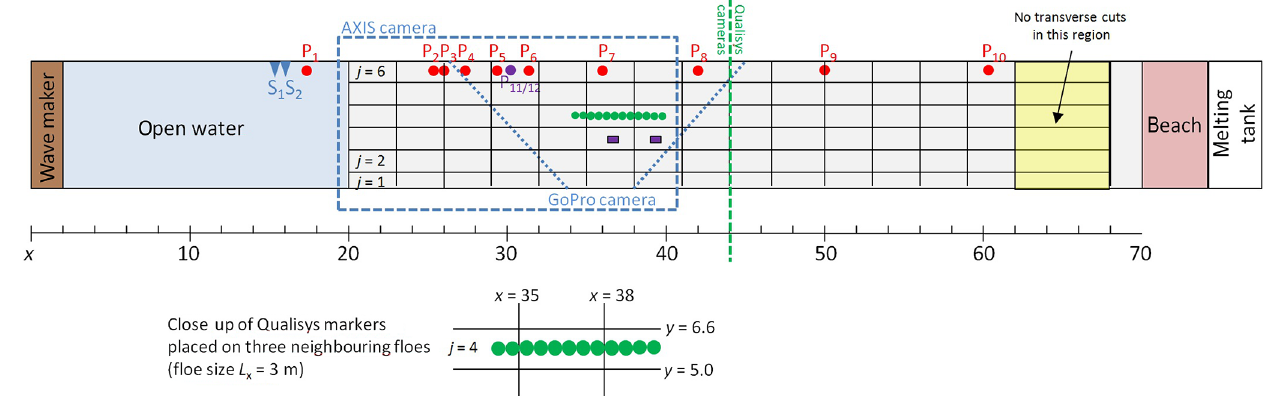
Figure 1. LS-WICE experiment set-up. The ice edge is located at x 0 = 20m, the grey area represents the ice sheet (at the stage when it was cut into floes with L x = 3m). Red dots numbered P 1 ,...,P 10 show positions of pressure sensors, point P 11 /P 12 shows position of a double pressure sensor (measuring at two different depths), and S 1 and S 2 show positions of ultrasound sensors. The dashed and dotted blue lines mark the fields of view of the AXIS camera mounted at the ceiling and the GoPro camera mounted at the side of the basin. Green dots mark the Qualisys markers placed on the fourth row of ice floes (shown in more detail in the schematic below the main figure), and violet rectangles show the two IMUs placed on the third row of floes.